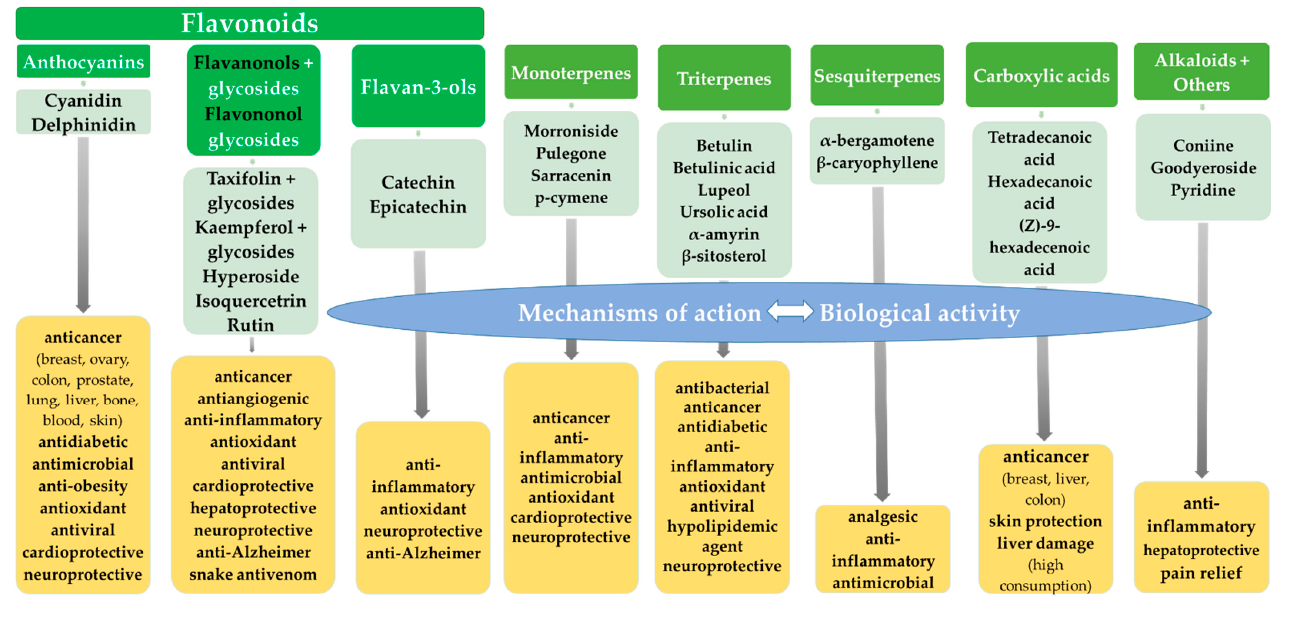
Figure 2. Biological activity of secondary metabolites from Sarraceniaceae plants.